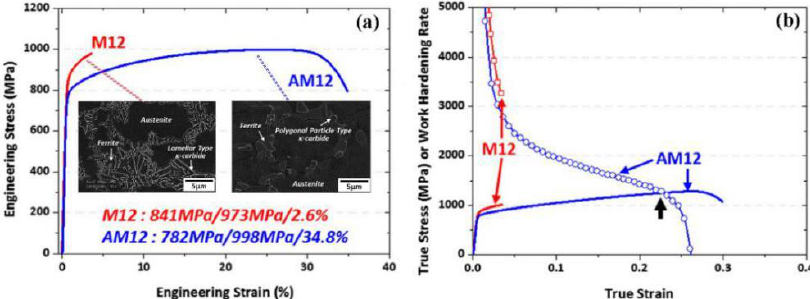
Figure 10. ( a ) Engineering stress–strain curves and microstructures, ( b ) true stress–strain curves and work hardening rate curves of hot-rolled alloy (M12) and annealing alloy (AM12) with the compositions of Fe-0.8C-12Mn-7Al (wt.%). (Adapted with permission from [76], copyright Elsevier, 2018).